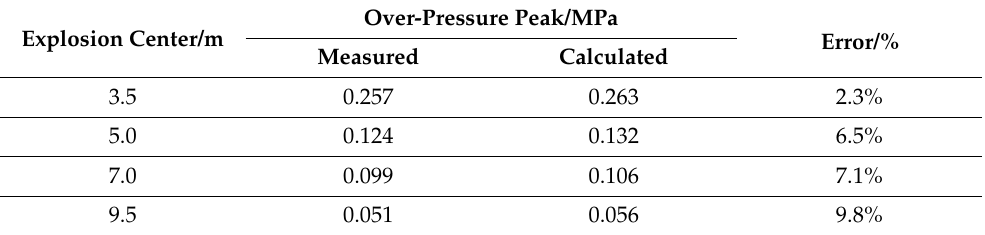
Table 3. Comparison of the numerical simulation results with the experimental results.